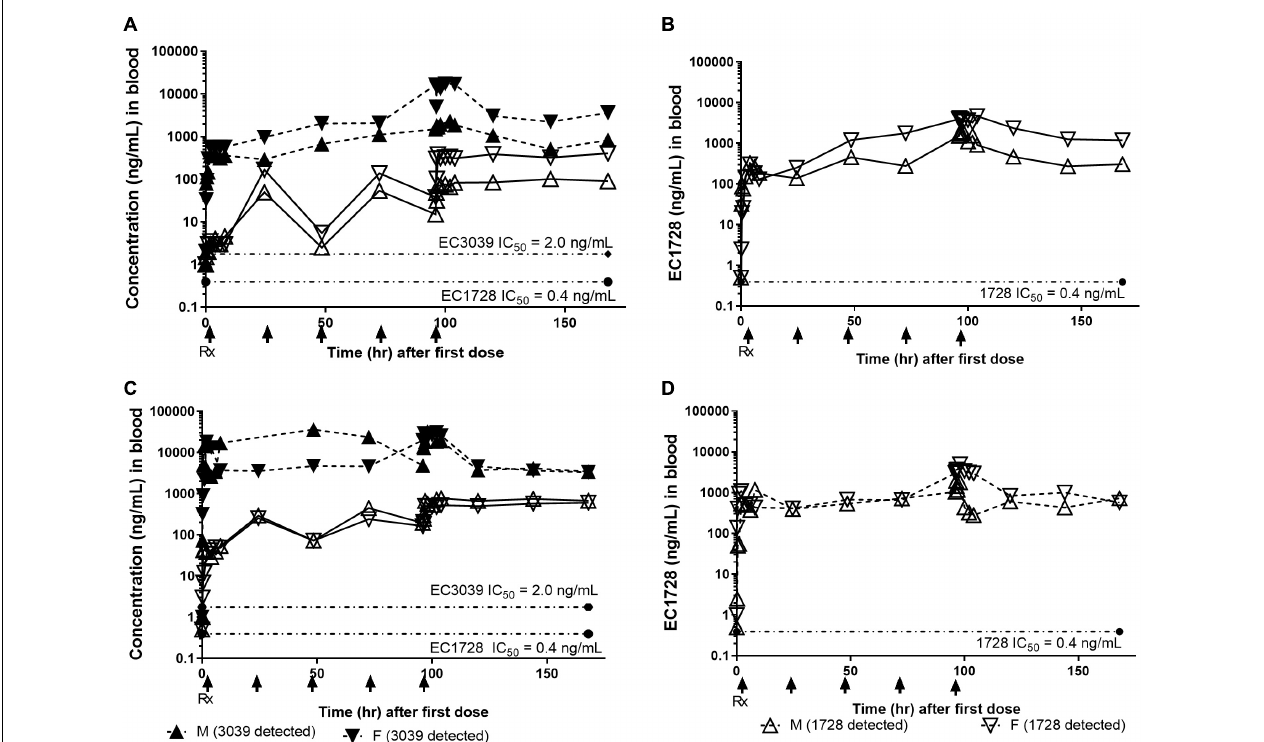
FIGURE 2 | Concentrations of EC3039 and EC1728 in the blood exceeded the IC 50 for sEH for all treatment groups for the duration of the study. The PK profile of animals treated with EC3039 (A,C) or EC1728 (B,D) in a satellite group of n = 2 dogs administered 1 mg/kg or 5 mg/kg orally once daily for 5 consecutive days is shown. Blood was collected at 0.25, 0.5, 1, 2, 4, 6, and 8 h after dosing on Day 1, and again on days 2 through 4 at 0.5 h after dosing. On Day 4, blood was collected immediately prior to dosing, and again at 0.25, 0.5, 1, 2, 4, 6, 8 ( ± 5 min), 24, 48, and 72 h ( ± 30 min) post treatment. Concentrations of EC1728 and EC3039 were well above the EC 50 for the study duration. Blood concentrations increased over the 5 days of dosing in all treatment groups, and T 1 / 2 calculated from the parent concentration predicts that steady-state is reached by day 5 for EC1728 and between days 5–8 for EC3039. Dogs administered EC3039 at 1 mg/kg (A) and 5 mg/kg (C) had detectable amounts of EC1728 in their blood presumably from demethylation of the urea by CYP450. The amount was proportional to EC3039 levels and above the EC 50 for sEH, although approximately 3 × lower than the dogs in the EC1728 treatment groups. A model could not be fitted for EC1728 detected from dogs administered EC3039 and T 1 / 2 were not calculated. Dogs administered EC1728 at either 1 mg/kg (B) and 5 mg/kg (D) had no detectable amounts of EC3039 in their blood. Drug concentrations did not show a clear dose response for dogs treated with EC1728, and dogs treated with 1 mg/kg of EC1728 (B) had approximately half the AUC as dogs treated with 5 mg/kg EC1728 (D) . TABLE 3 | PK parameters of EC3039 and EC1728 administered to a satellite group of dogs for 5 days by oral gavage. Gender Compound detected C max (ng/mL) AUC last (h ∗ ng/mL) T 1 / 2 (h) Day 1 Day